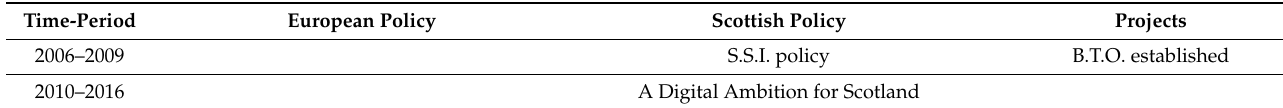
Table 3. Policies on improving broadband connectivity/adoption/use in remote-rural Scotland (Jan 2006–May